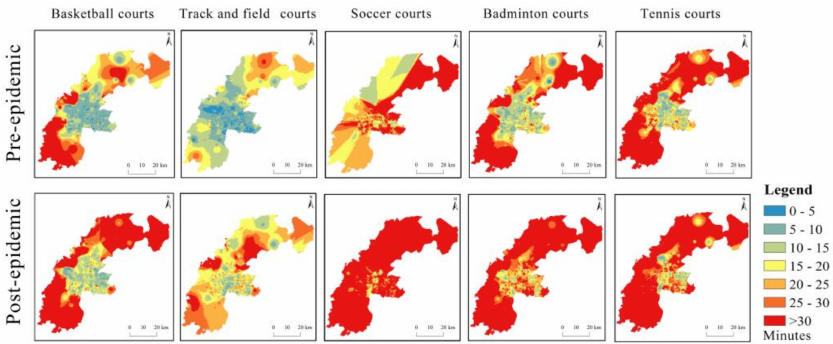
Figure 16. The walking accessibility for different types of outdoor sports